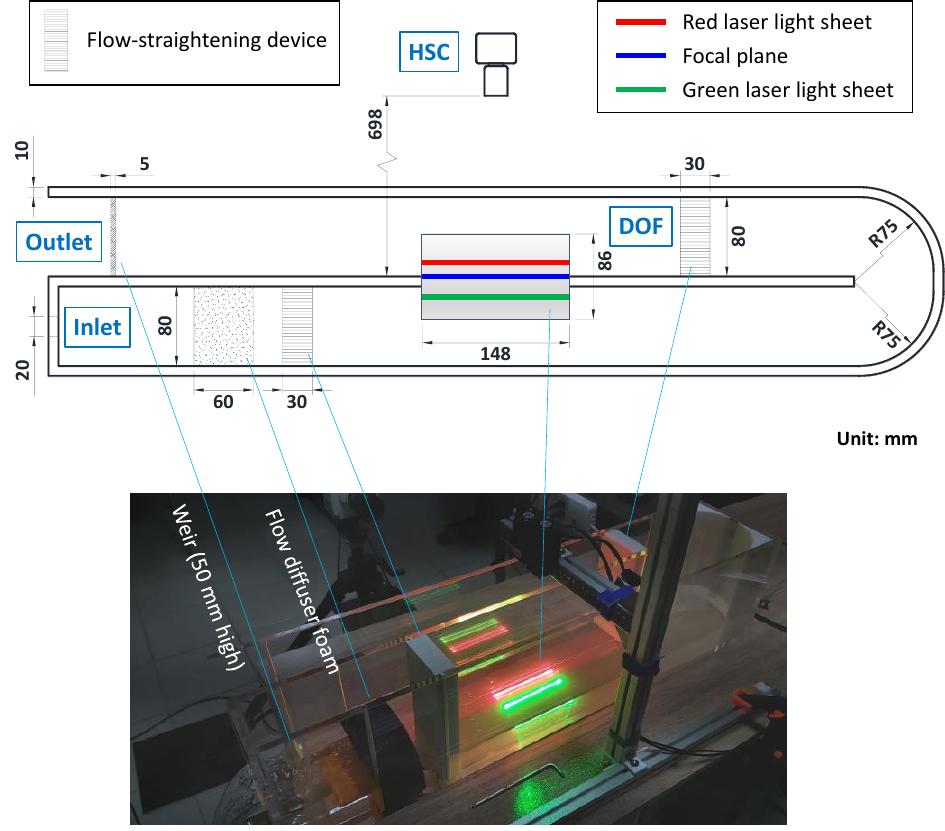
Figure 5. PIV setup for a stratified crossflow condition generated by a U-shaped channel. Top and bottom panels are the top-view drawing and photo of the experiment, respectively.